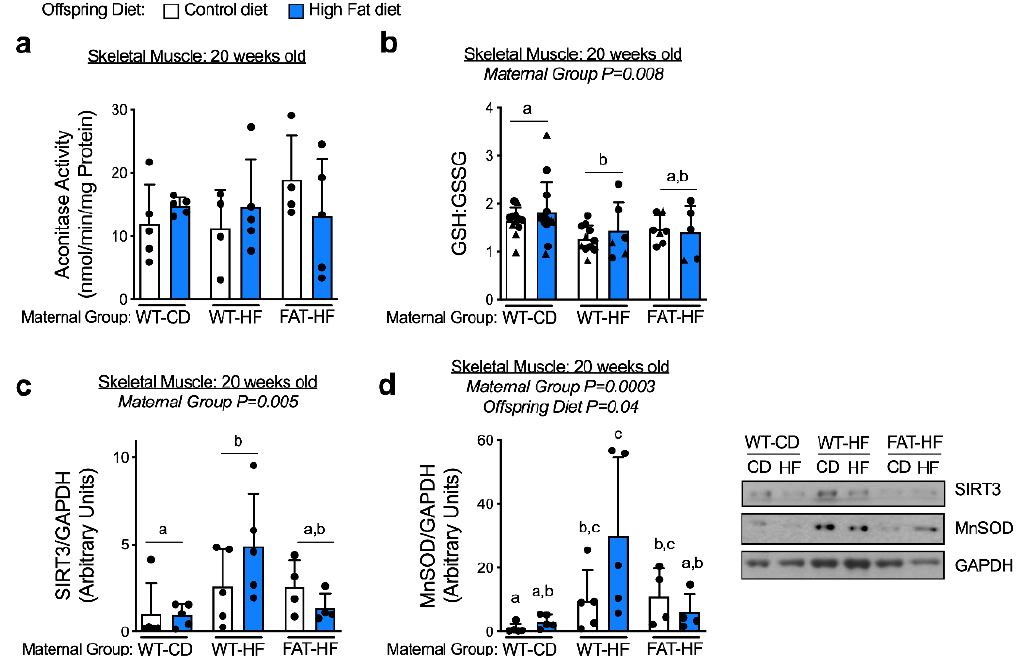
Figure 7. Maternal fat-1 transgene partially protects from perturbations in antioxidant defense and redox balance. Skeletal muscle aconitase enzyme activity ( a ), oxidized:reduced glutathione ratio ( b ), and SIRT3 ( c ) and MnSOD ( d ) protein content were measured in offspring of WT dams fed a control diet (WT-CD), or offspring of WT or fat-1 hemizygous dams fed a high-fat diet (WT-HF and FAT-HF, respectively) throughout pregnancy and lactation. All offspring were WT males (circles) and WT females (triangles) and were weaned to control or high-fat diet (post-weaning diet). Data are presented as mean ± SD. Different letters above bars denote statistically significant differences between those bars at p < 0.05 significance level.